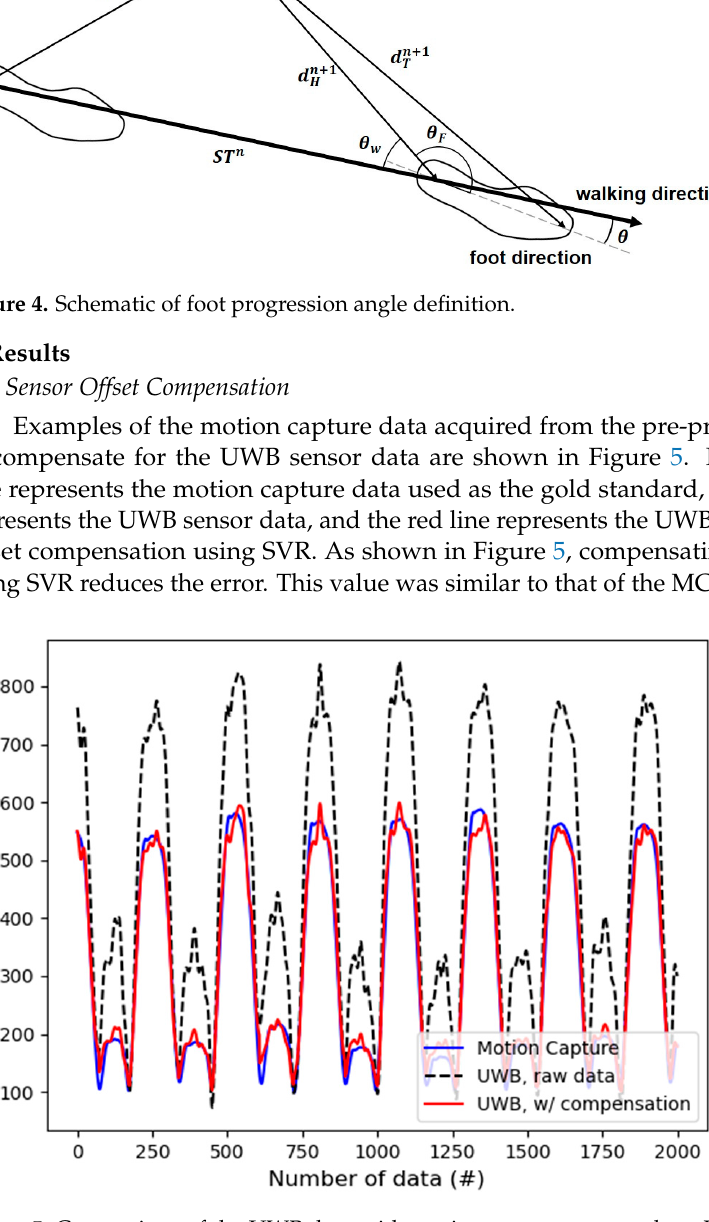
Figure 4. Schematic of foot progression angle de fi nition.